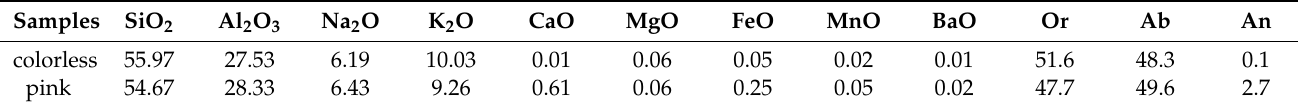
Table 1. Electron-microprobe chemical compositions of orthoclase